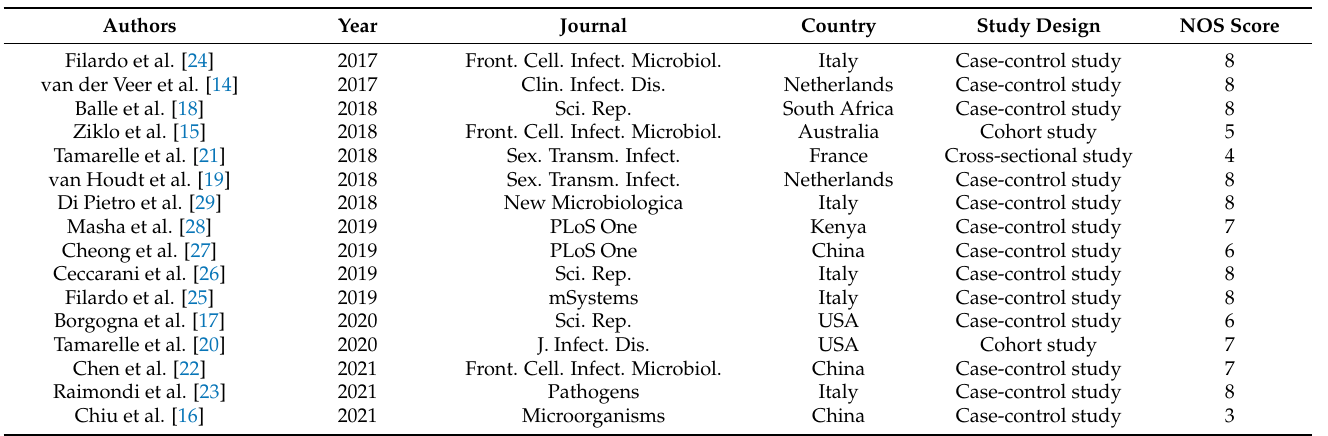
Table 2. Newcastle-Ottawa scoring (NOS) results of the included studies in relation to the study